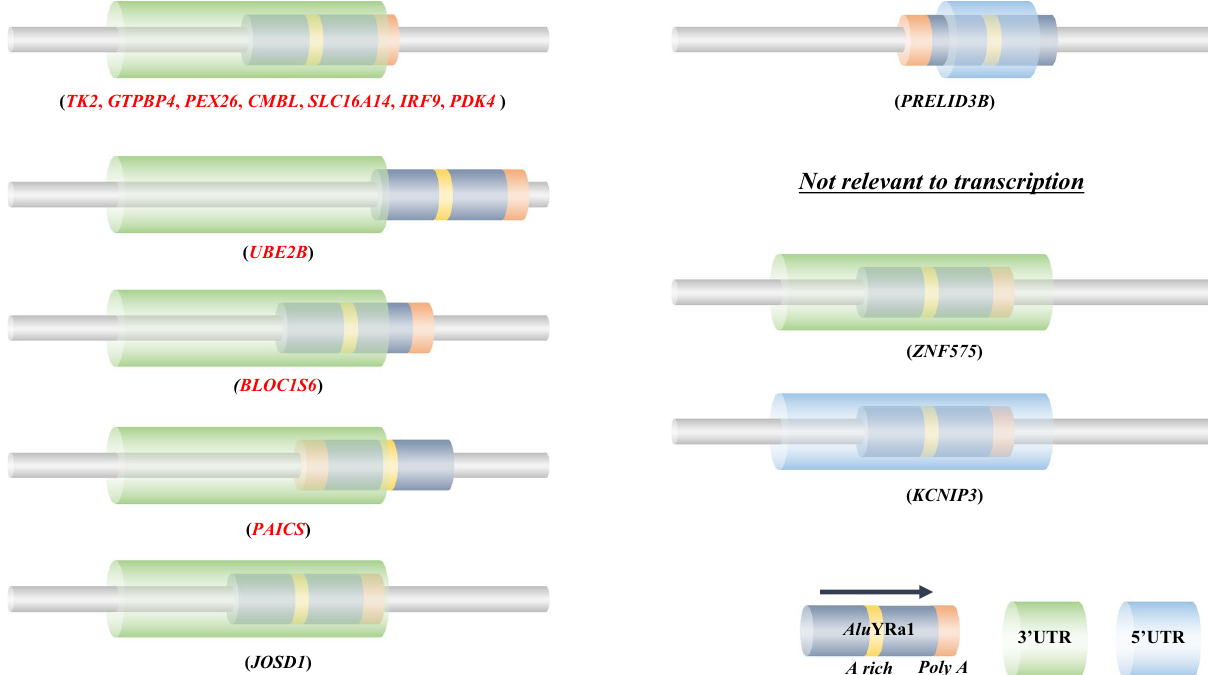
Figure 6. Structural analysis of sense-oriented Alu YRa1 insertion in cynomolgus macaque. Fourteen genes located at the UTR of the transcript were identified. These Alu YRa1s were classified into three categories based on their characteristics. Green and blue horizontal cylinders represent 3 ′ UTR and 5 ′ UTR, respectively. Black horizontal cylinder with a yellow one (A-rich region) and an orange one (poly-A tail region) represent Alu YRa1. Black arrow indicates the insertion direction of Alu YRa1. UTR; untranslated